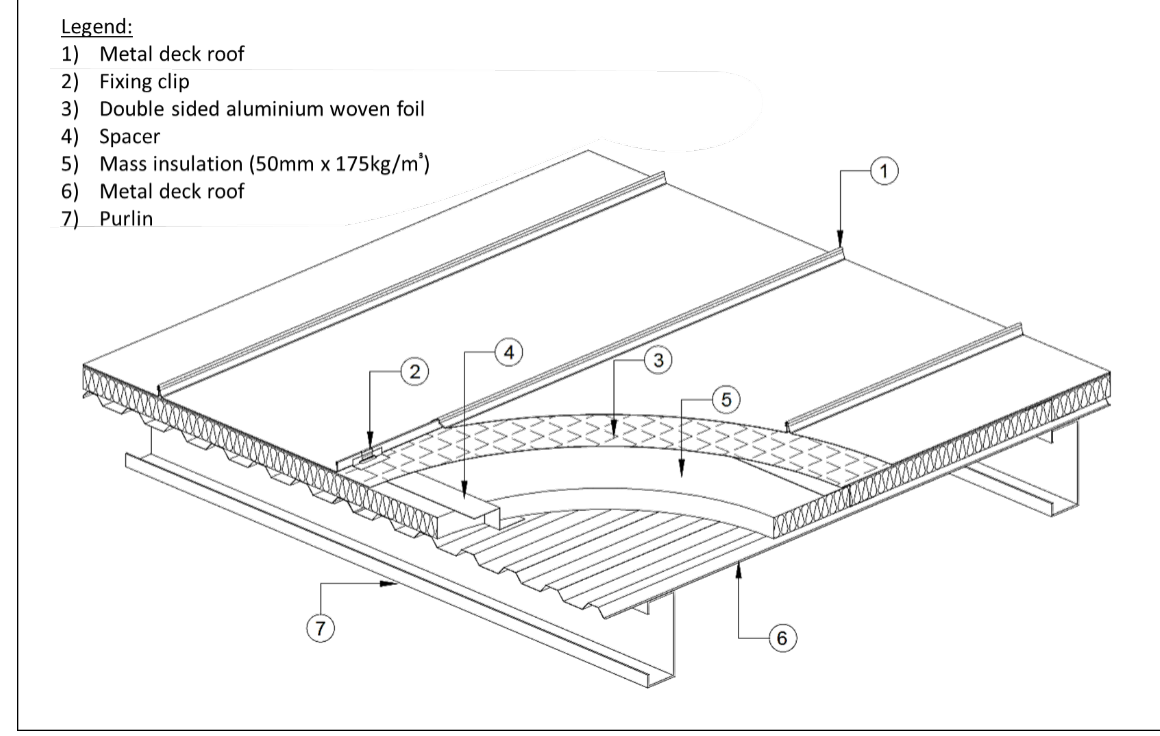
Figure 5: RI used as vapor barrier (Source: Swissma Roofing Malaysia)